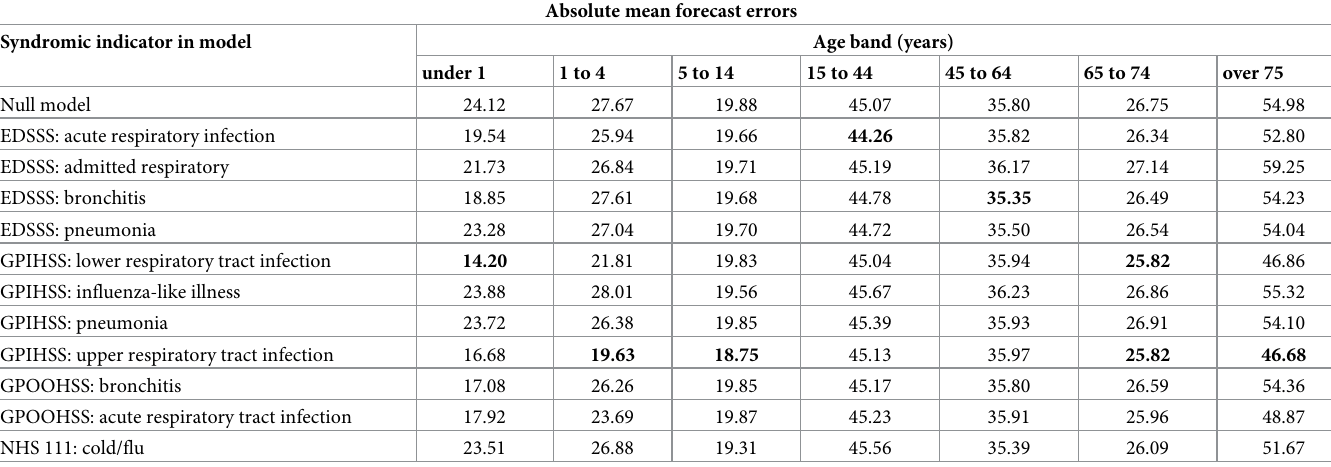
Absolute mean forecast errors